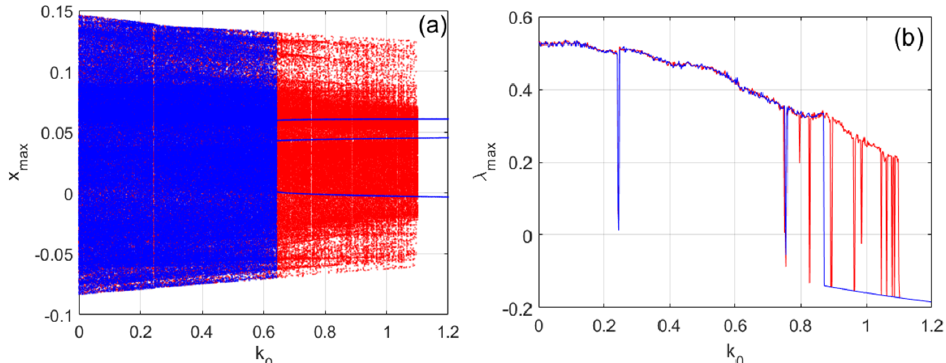
Figure 3. ( a ) Bifurcation diagram showing the local maxima of the state variable of the tabu learning neurons versus the electromagnetic induction strength k 0 and ( b ) shows the corresponding Lyapunov exponents as a function of k 0 . The red color points/lines were obtained based on the continua- tion technique using initial conditions [0;0;0], while the blue ones were obtained with fixed initial conditions